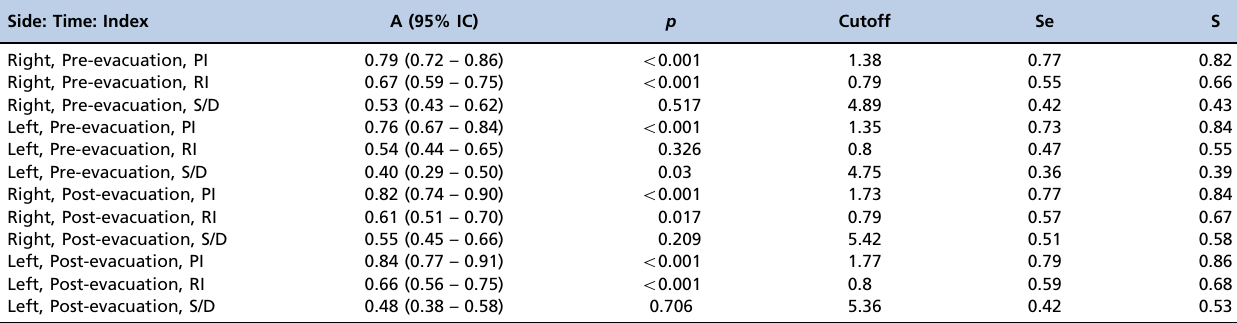
Table 4 - PI, RI and S/D cutoff values; sensitivity; and specificity for predicting gestational trophoblastic neoplasia following a complete hydatidiform mole. Side: Time: Index A (95% IC) p Cutoff Se S Right, Pre-evacuation, PI 0.79 (0.72 –